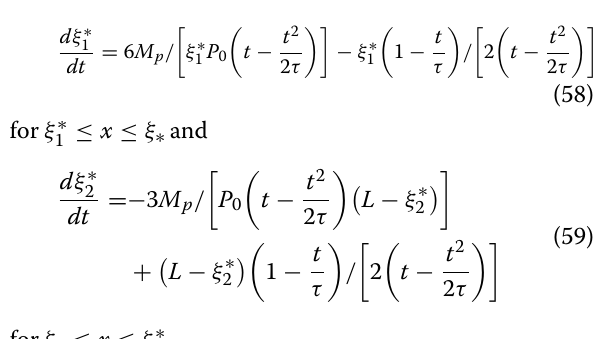
Fig. 20 Evolution of displacement